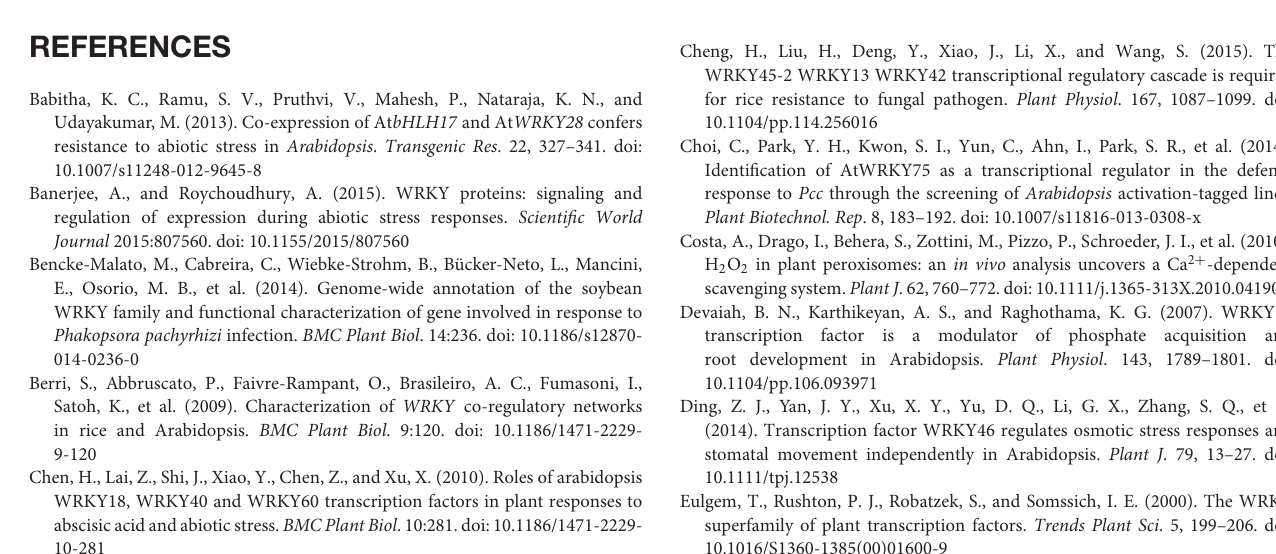
Figure S1 | Sequence logos for conserved motifs identified in MeWRKYs by MEME analysis. Table S1 | Primers used in qRT-PCR analysis. Table S2 | Characteristics of MeWRKY family in cassava. Table S3 | The accession numbers of WRKYs in cassava and Arabidopsis. Table S4 | The expression data of the cassava WRKY genes in different tissues.